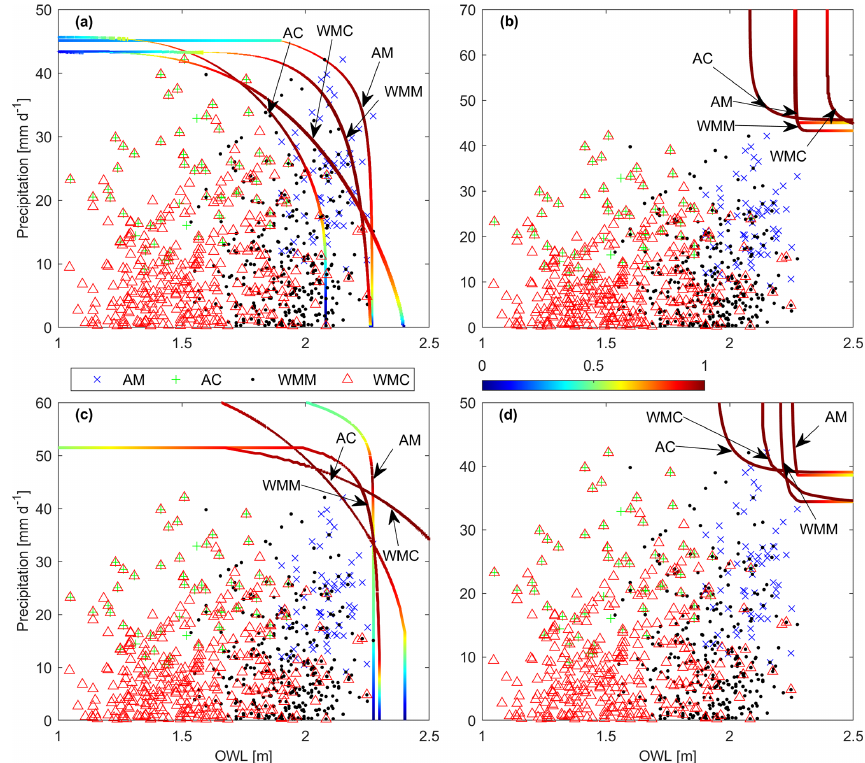
Figure 9. San Diego (a) AND, (b) OR, (c) SK, and (d) K hazard scenarios for annual maximum (AM; cross), annual coinciding (AC; plus), wet-season monthly maximum (WMM; dot), and wet-season monthly coinciding (WMC; triangle) data and 100-year isolines using the BB1 copula. Sampling labels point to the mostly likely value on their respective isolines.